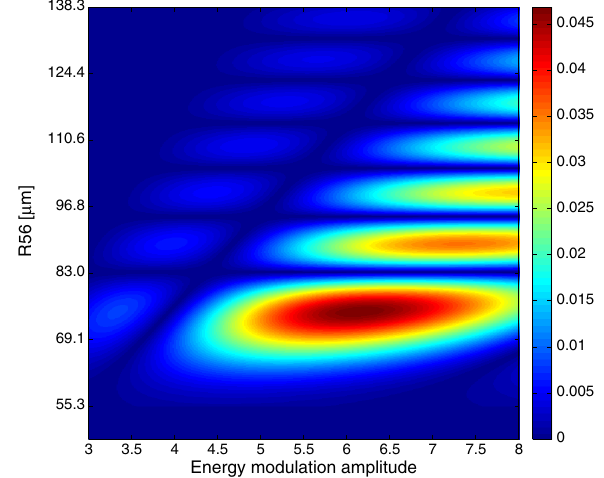
FIG. 7. The 30th harmonic bunching factor in a single-stage HGHG vs the energy modulation amplitude and the strength of the dispersion. A saddlelike energy distribution from ELEGANT with a rms energy spread of 38 keV is used.